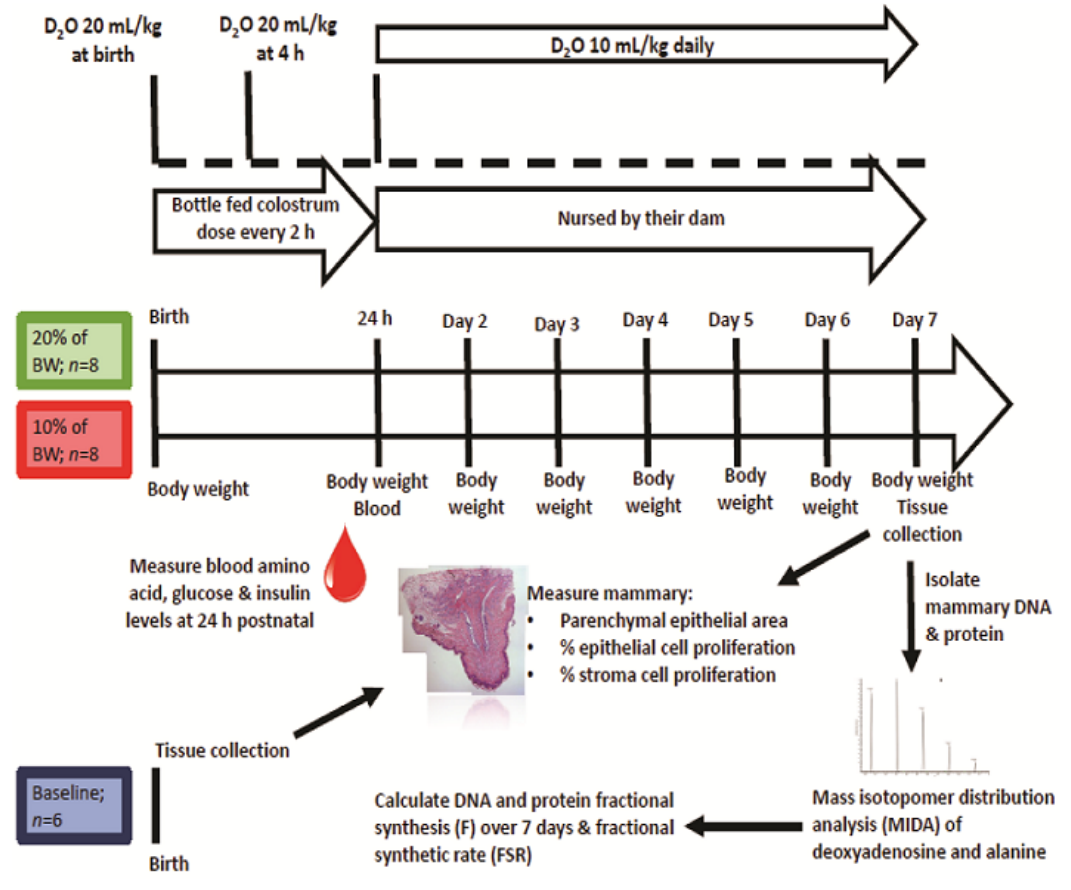
Figure 1. Schematic of study design.